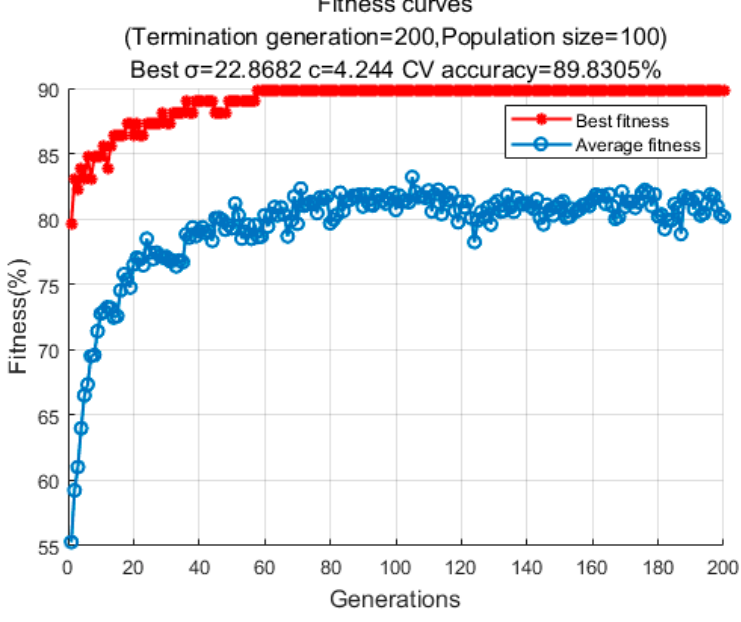
Figure 3. Fitness curves of genetic algorithm.